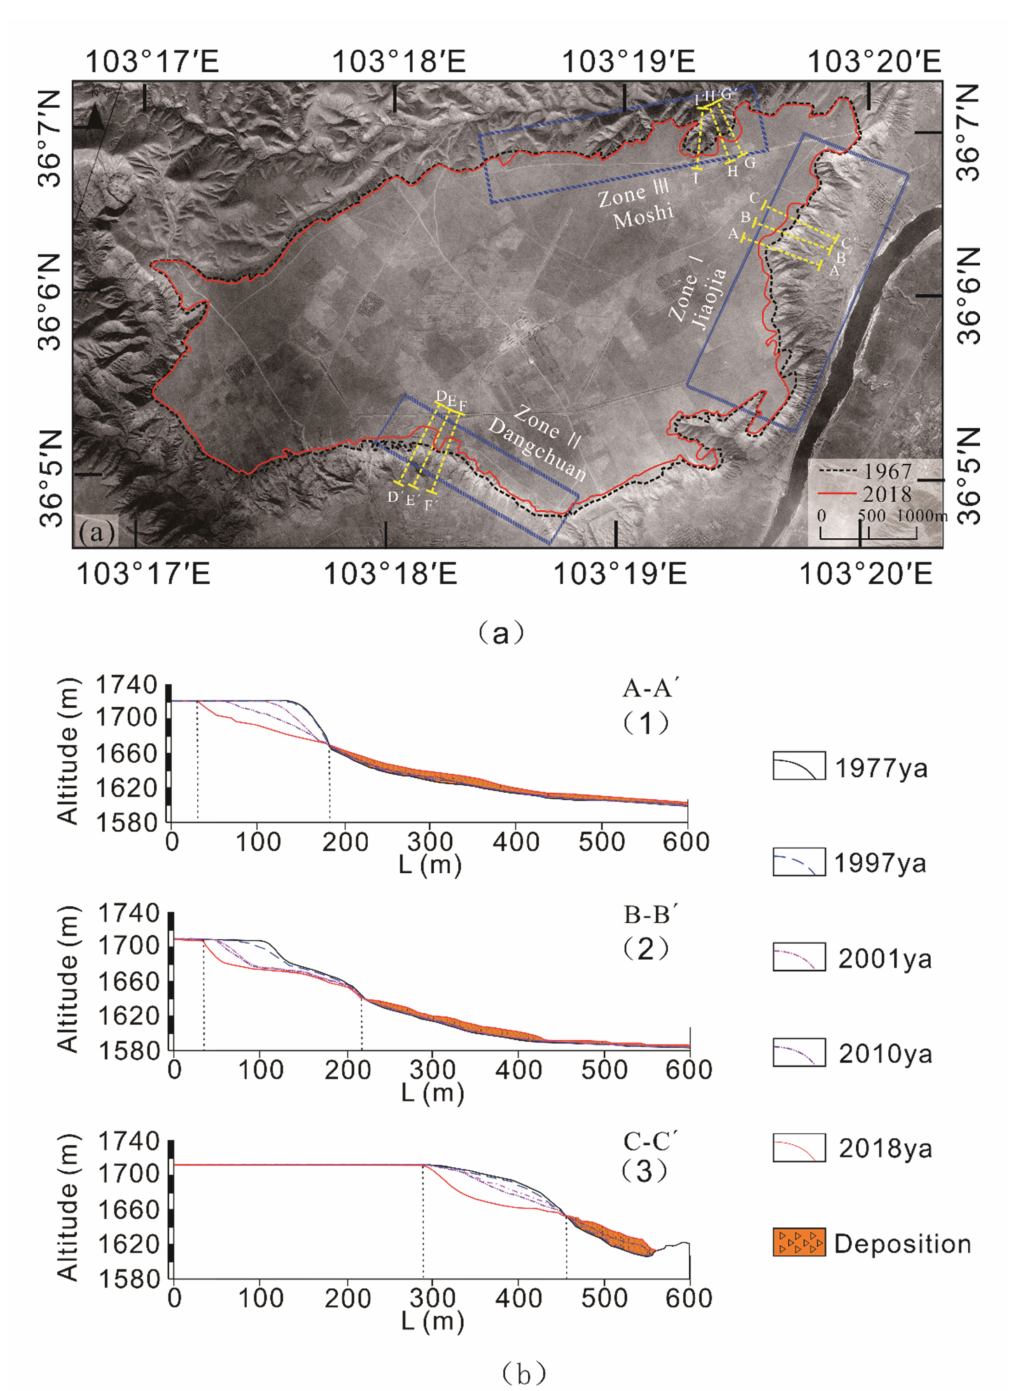
Figure 2. Evolution of tableland edge from 1967 to 2018. ( a ) The results of degradation distance performed; ( b ) the images in zone II at different